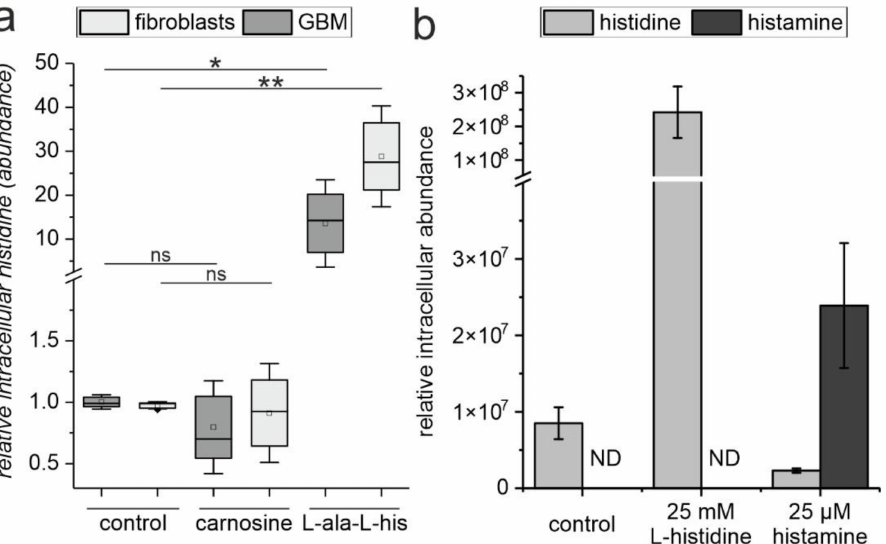
Figure 3. Release of histidine from carnosine and LA-LH and formation of histamine from histidine in fibroblasts and glioblastoma cells. ( a ) Four different glioblastoma cell lines and five different fibroblast cultures were treated with carnosine or L -alanyl- L -histidine (LA-LH) (both 50 mM) or vehicle control for 48 h. Afterwards, metabolites were extracted and intracellular histidine was determined by LC–MS. Results are presented as box plots that were obtained from the median of the replicates of each cell culture. ( b ) T98G cells were treated with 25 mM L-histidine, 25 µ M histamine, or vehicle control for 48 h. Afterwards, metabolites were extracted, and intracellular histamine and L -histidine were determined by LC–MS. Statistical analysis was performed using a one-way ANOVA with the Games–Howell post hoc test. The level of significance is indicated as: *: p < 0.05; **: p <